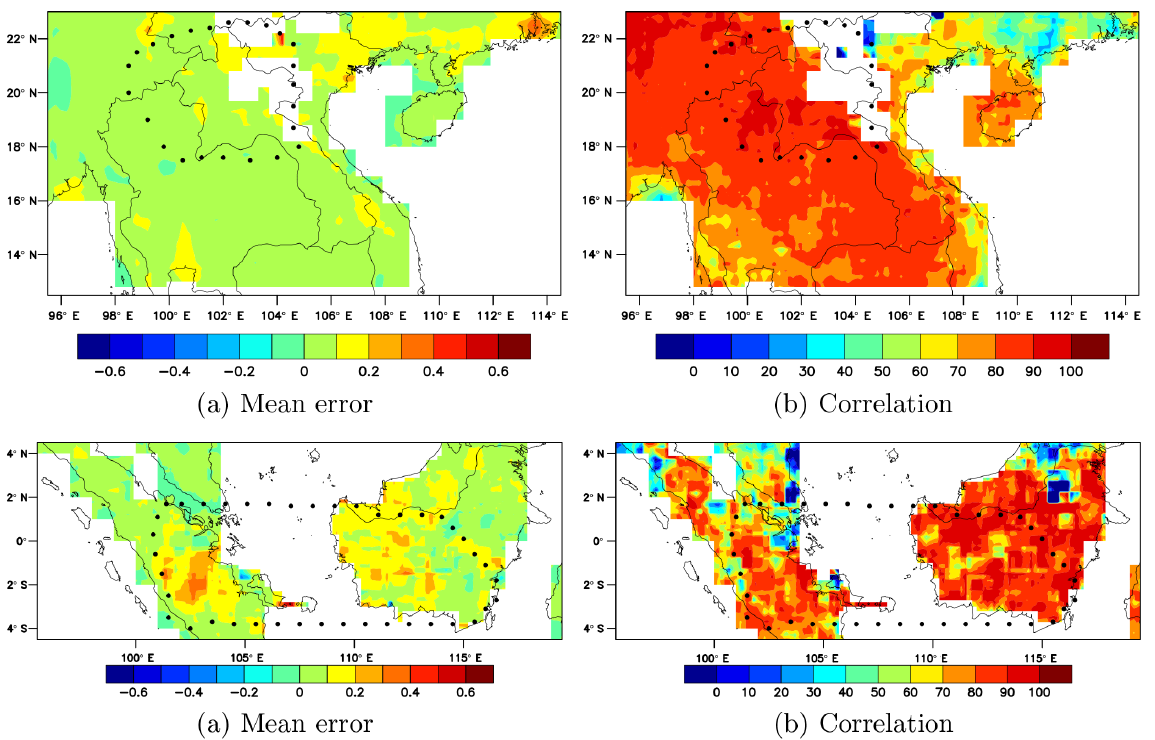
Figure 7. Basic statistics between MISR and AOD north (a, b) and AOD south (a, b) on a monthly basis (2001–2013). Regions of highest AOD variability from the EOF analysis are delineated by black dots. Within the northern region the mean correlation is 84.8% and the average is 77.3% (mean error is 0.06), while in the southern region the mean correlation is 79.2% and the average is 72.4% (mean error is 0.08). The mean errors are given on the left-hand side, while the correlations are given on the right-hand side.